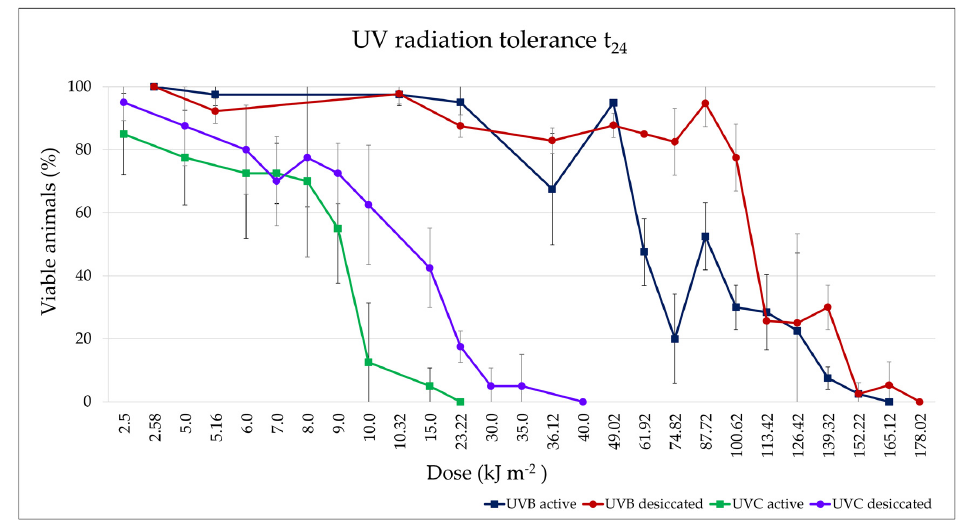
Figure 9. UVB (purple, red) and UVC (green, blue) tolerance of M. kyoukenus sp. nov.: final survivals (t 24 ) of active and desiccated animals after exposure to increasing doses of UV radiation. For each tested UV dose, the mean percentage of viable animals and its standard deviation are